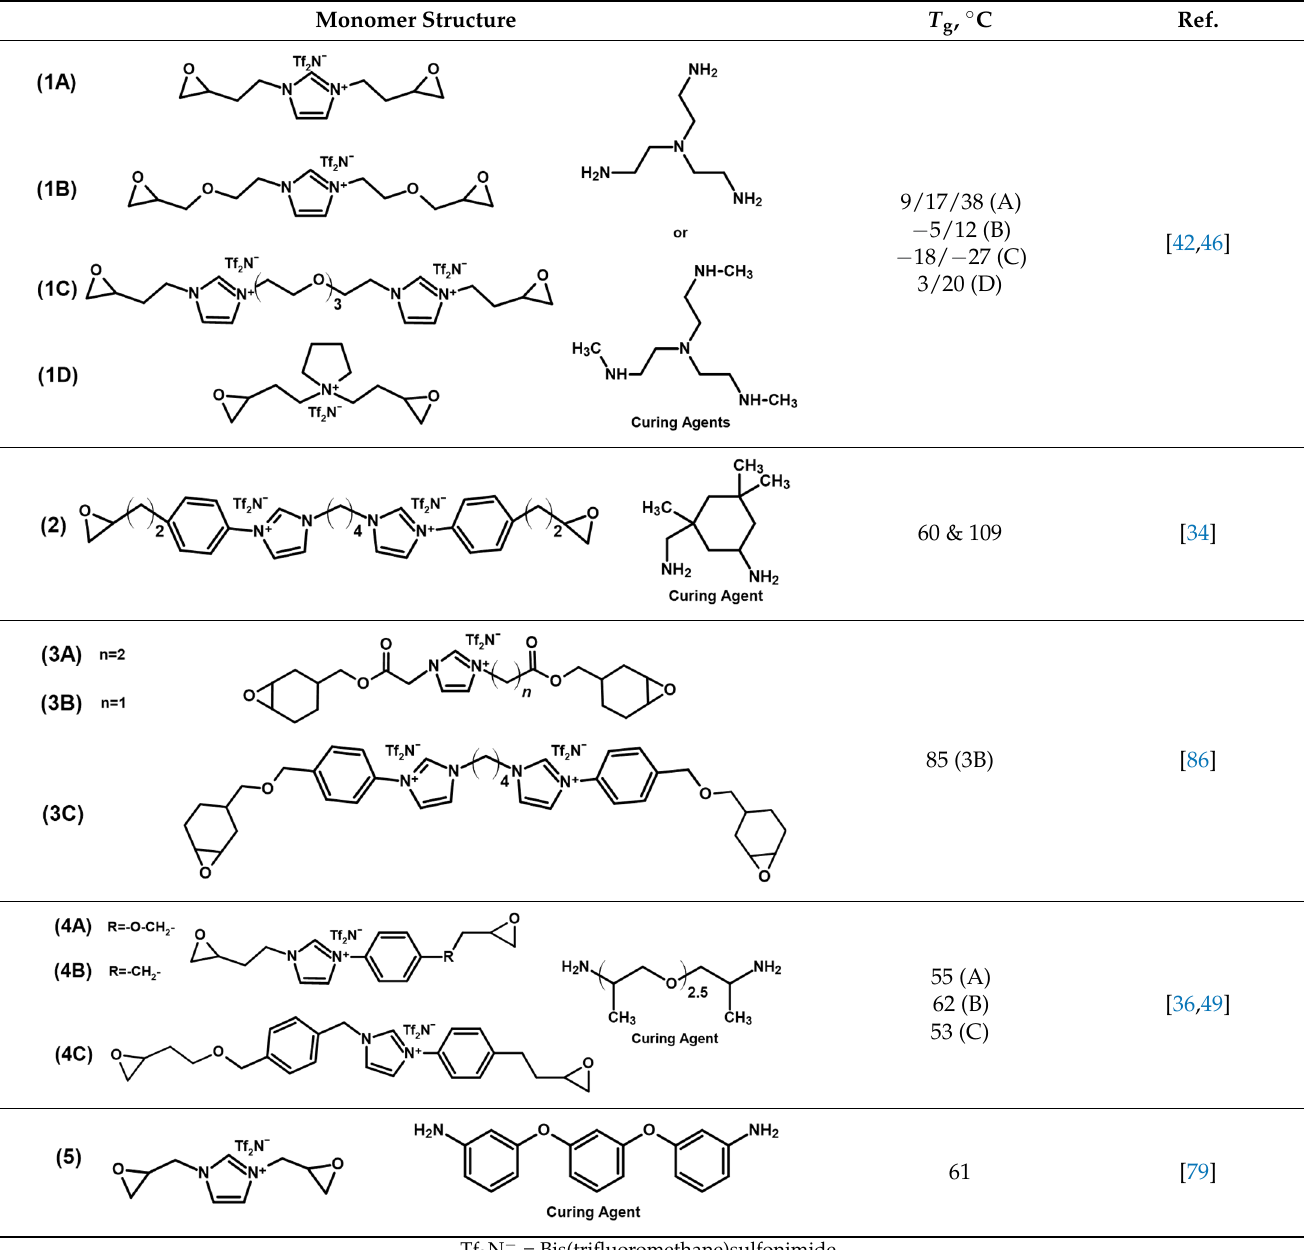
Table 1. Overview of PILs based on epoxy functional imidazolium ionic liquids reported in literature.